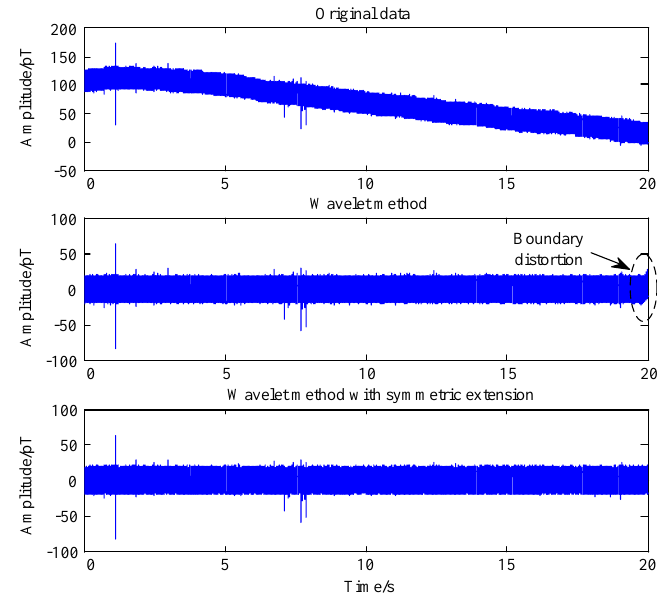
Figure 3. Comparison of one section of 20 ms length of the time record after baseline